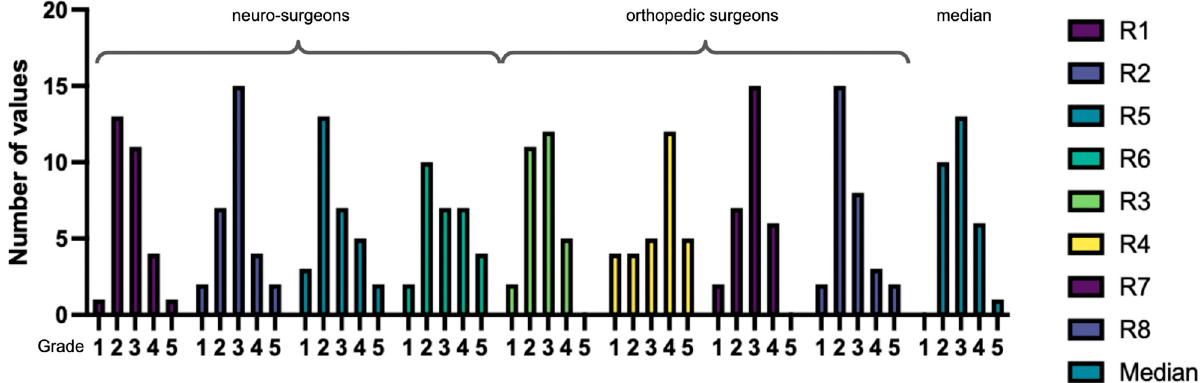
Figure 5. Histograms of subjective overall grades in the median (column 1) and raters 1 to 8 (col- umns 2 to 9). 2 to